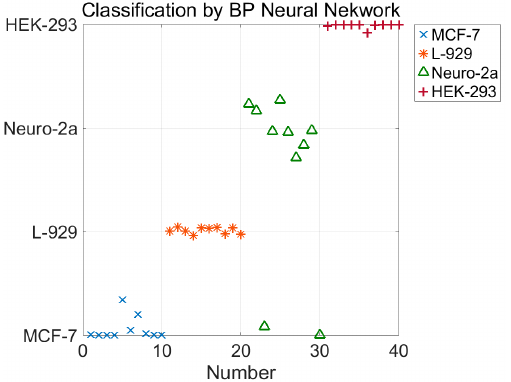
Figure 7. Classification result of the four types of cells by the backpropagation (BP) neural network. In the testing set, each type of cell has 10 test data. Among all 40 test data for the four cell types, only two points of Neuro-2a were misclassified. The success rate of the classification is 95%.